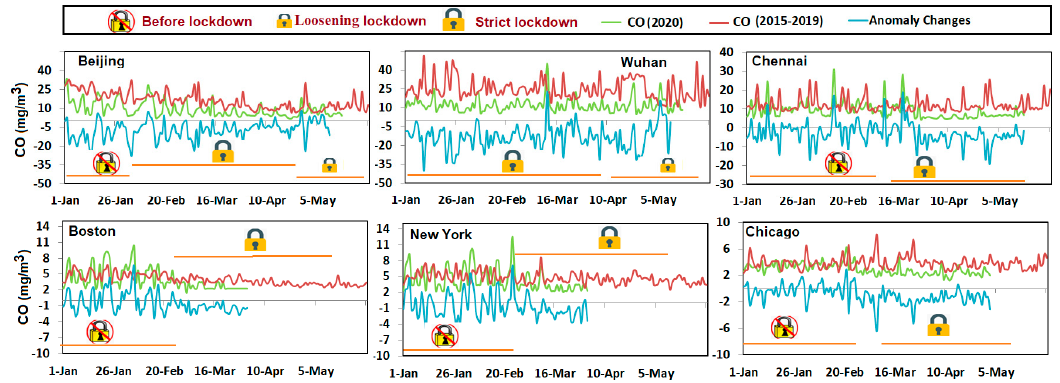
Figure 9. Daily mean dataset of CO and its anomaly changes in different global metropolitan cities in 2020 against the baseline (average of 2015–2019).